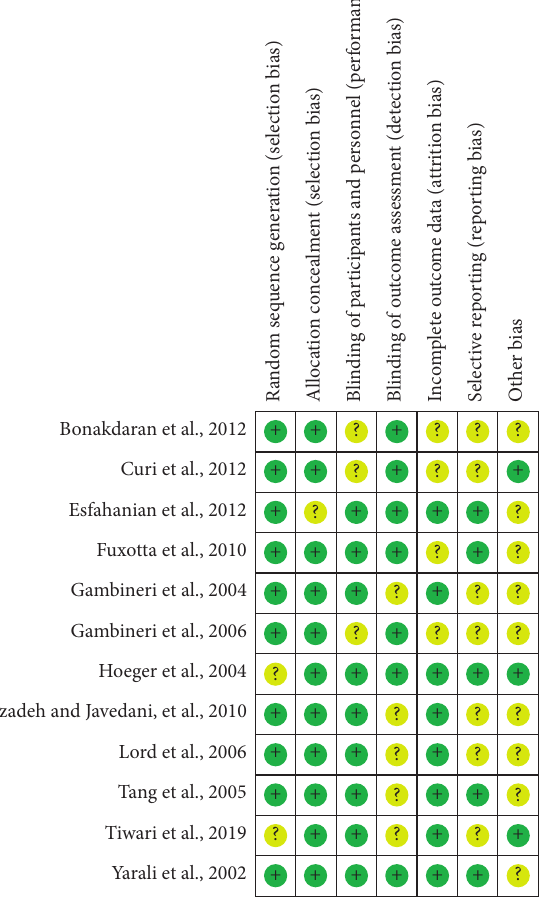
Figure 2: Risk of bias summary: review of authors’ judgements about each risk of bias item for each included